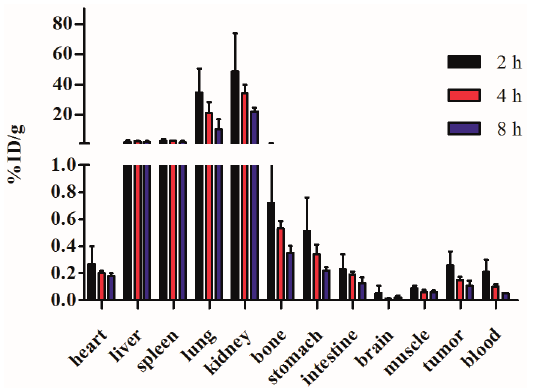
Figure 6. Biodistribution of the 99m Tc-RGD4C β L in xenograft-bearing rats. Data